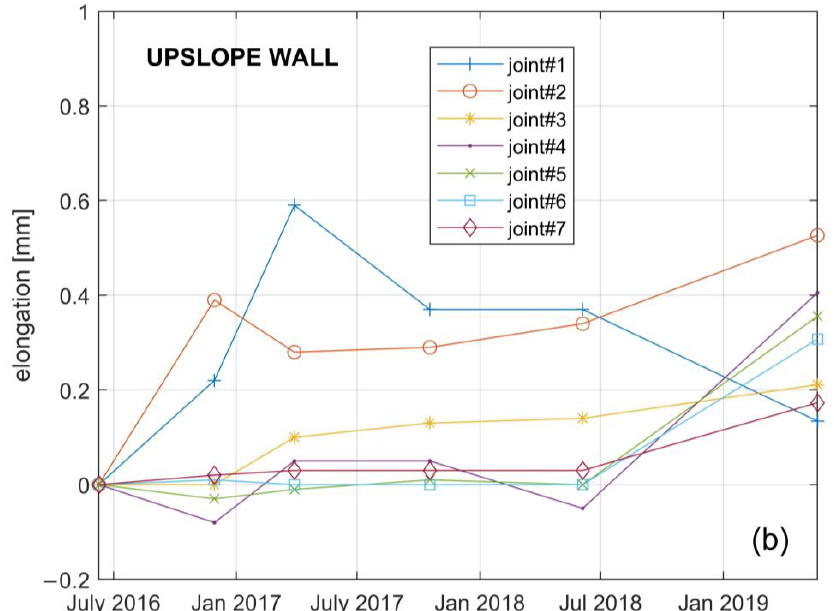
Figure 11. Elongation against time of the optical fiber, corresponding to the tunnel joints along the 315 ( a ) downslope or ( b ) upslope sidewall. 316 ( a ) downslope or ( b ) upslope